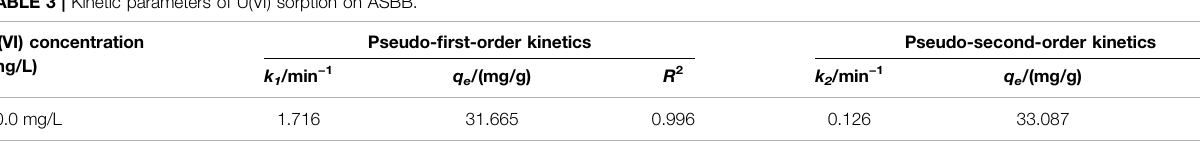
TABLE 3 | Kinetic parameters of U(VI) sorption on ASBB. U(VI) concentration (mg/L)